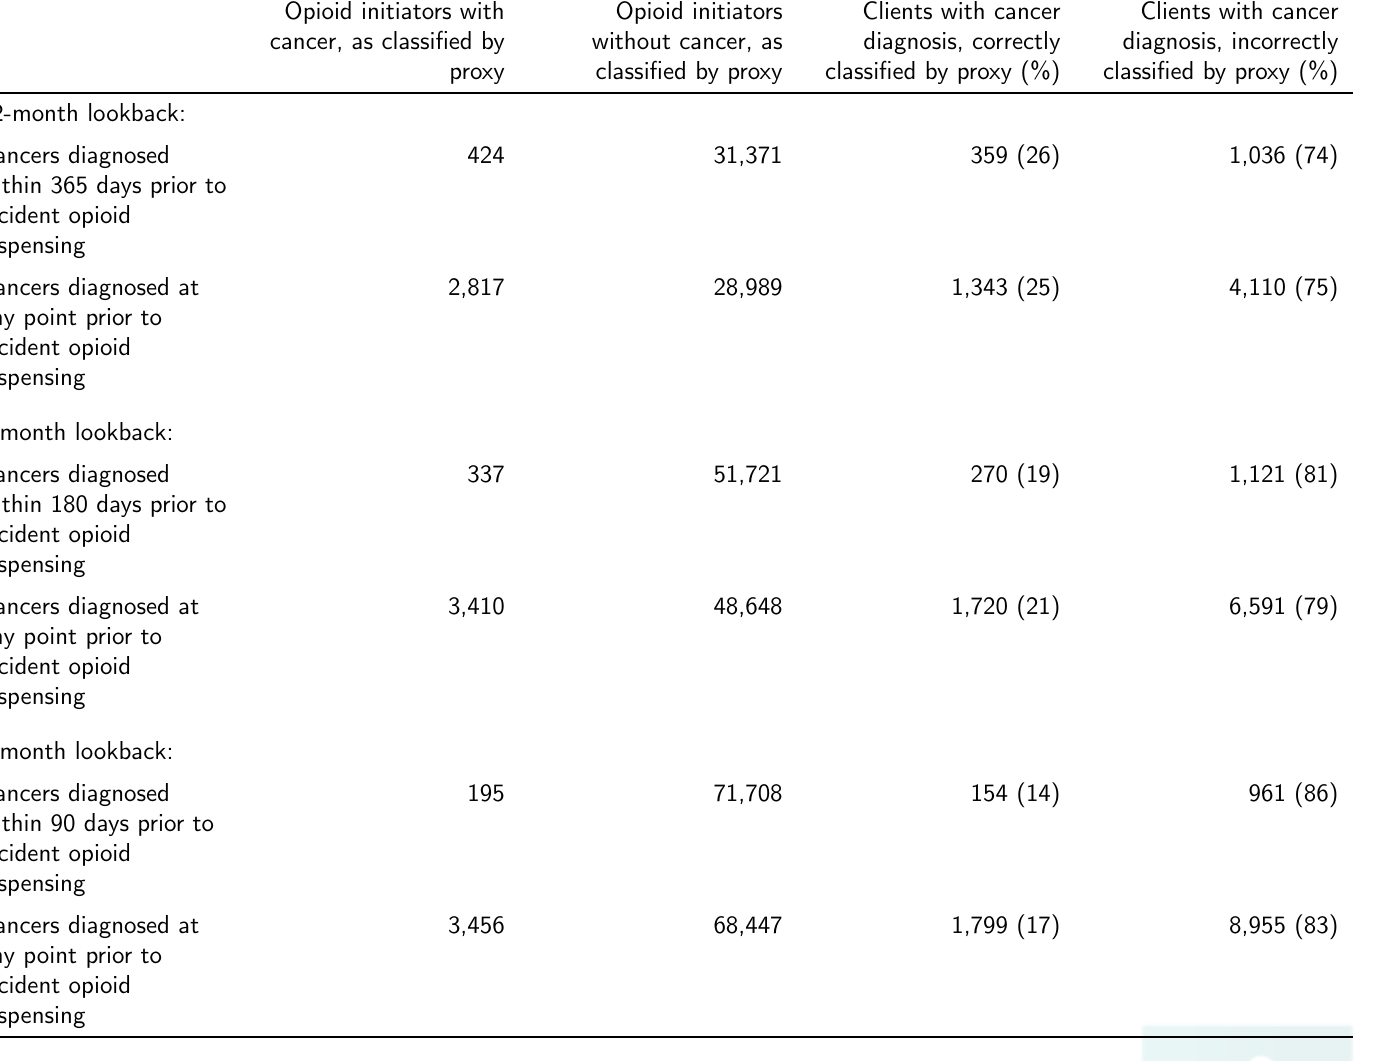
Table 3: Classification of people initiating opioids with and without a cancer diagnoses by lookback period Opioid initiators with Opioid initiators Clients with cancer Clients with cancer cancer, as classified by without cancer, as diagnosis, correctly diagnosis, incorrectly proxy classified by proxy classified by proxy (%) classified by proxy